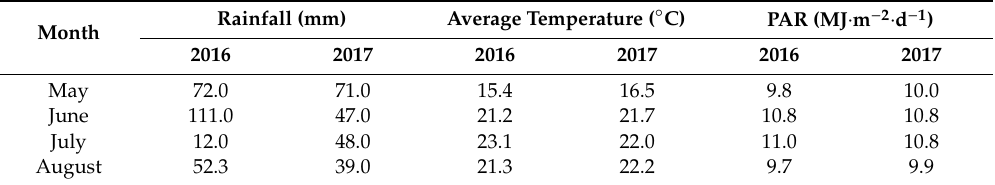
Table 1. Mean monthly values of rainfall and temperatures at the experimental site